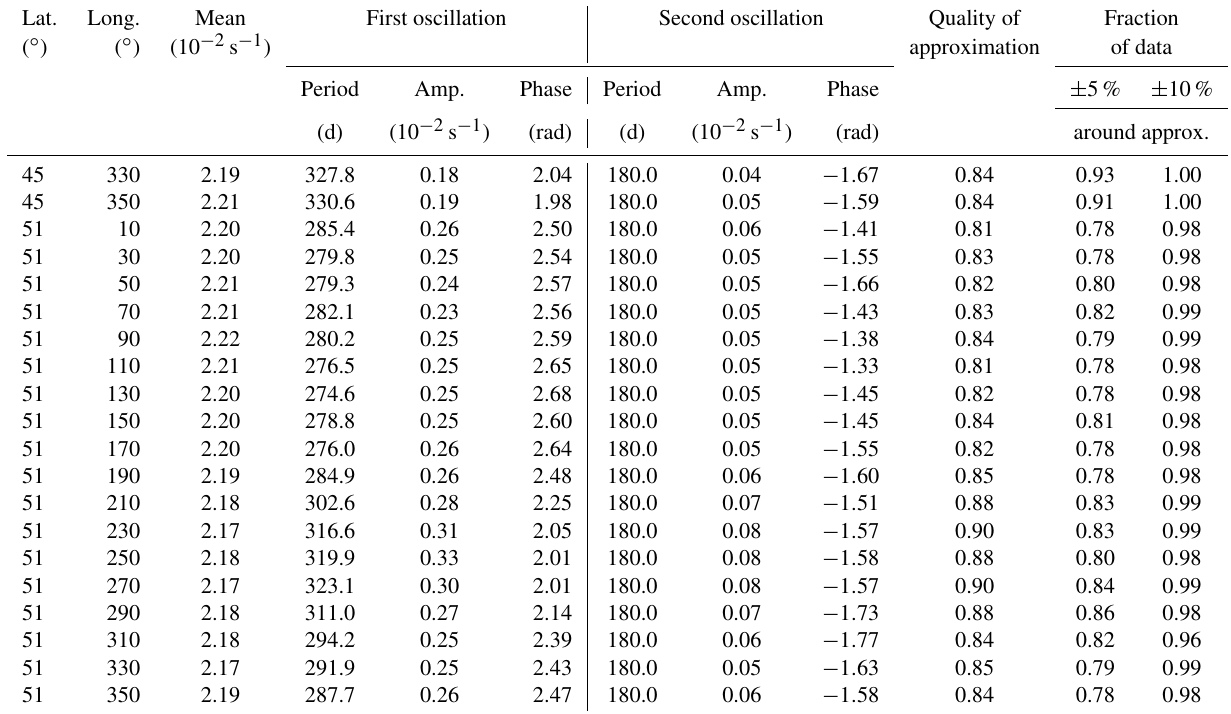
Table 2. Shown are the mean difference per hour and its variance for the OH ∗ -equivalent BV frequency measured during the same night for the different latitudinal intervals ( − 45 ± 5 ◦ until + 45 ± 5 ◦ , − 51 ± 1 ◦ and + 51 ± 1 ◦ ). Latitude Mean hourly